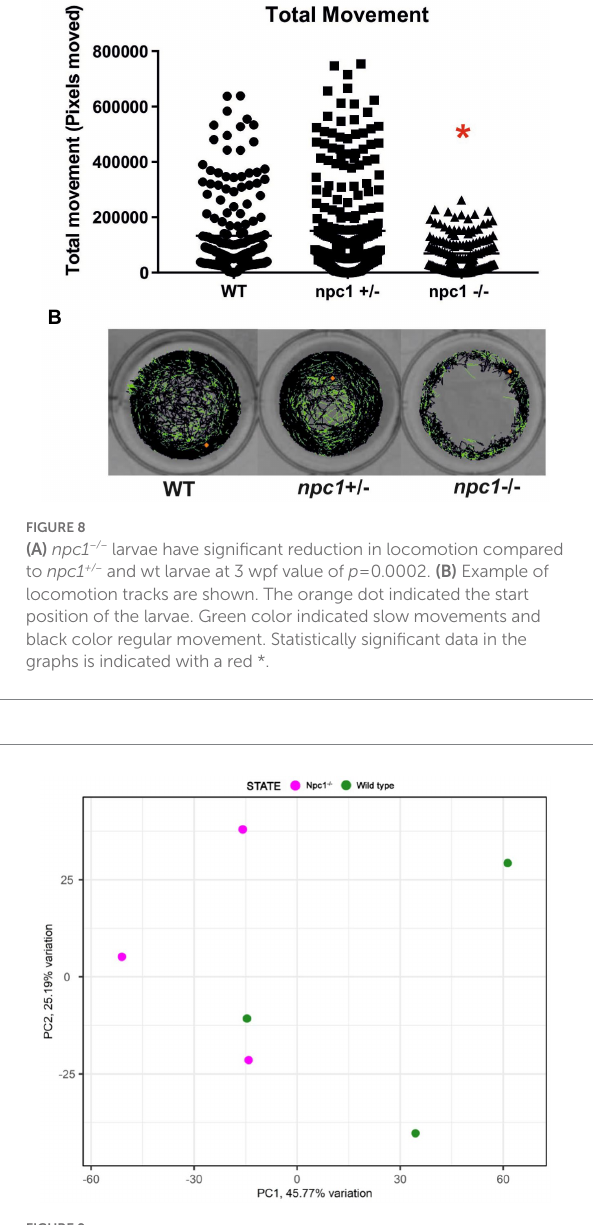
FIGURE 9 Principal component analysis of the RNAseq